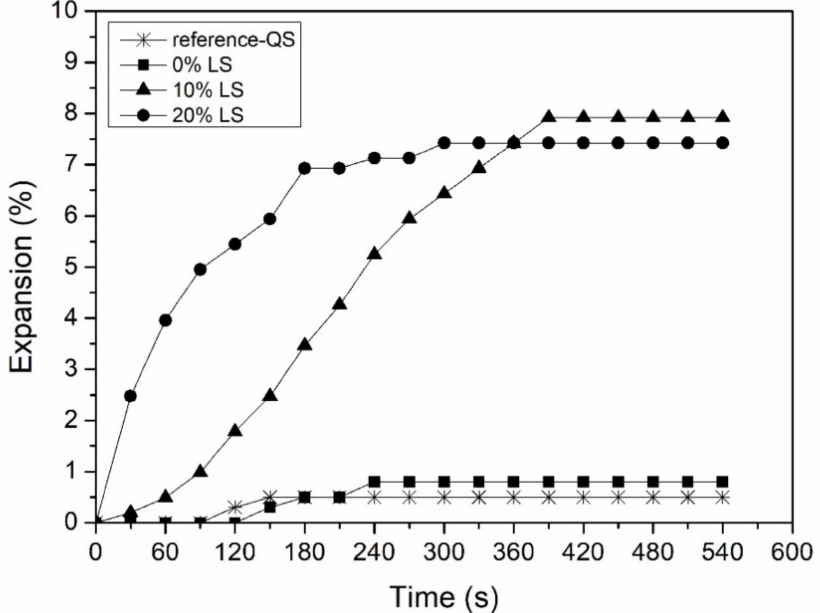
Figure 3. Expansion (before setting) of MAPC mortar samples with limestone fines (LS) at different dosage of 0%, 10%, 20% (by weight of